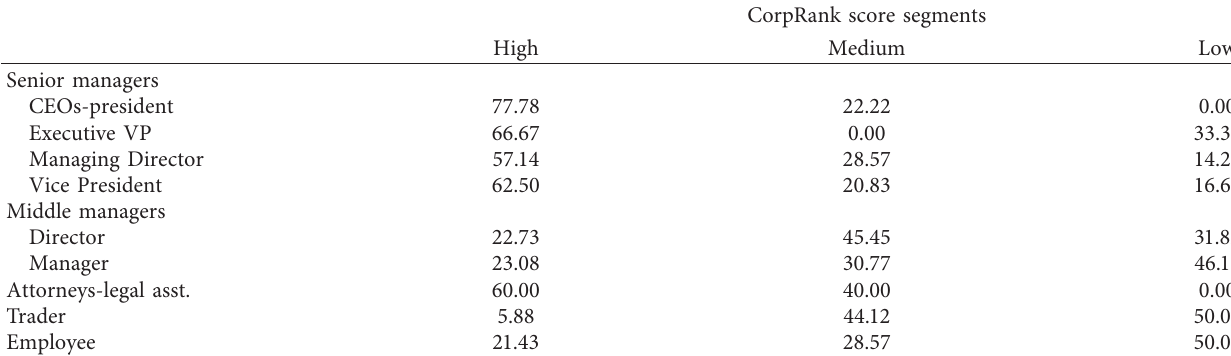
Table 5: Proportion (%) of Enron‘s employees in occupational categories by CorpRank score segments.